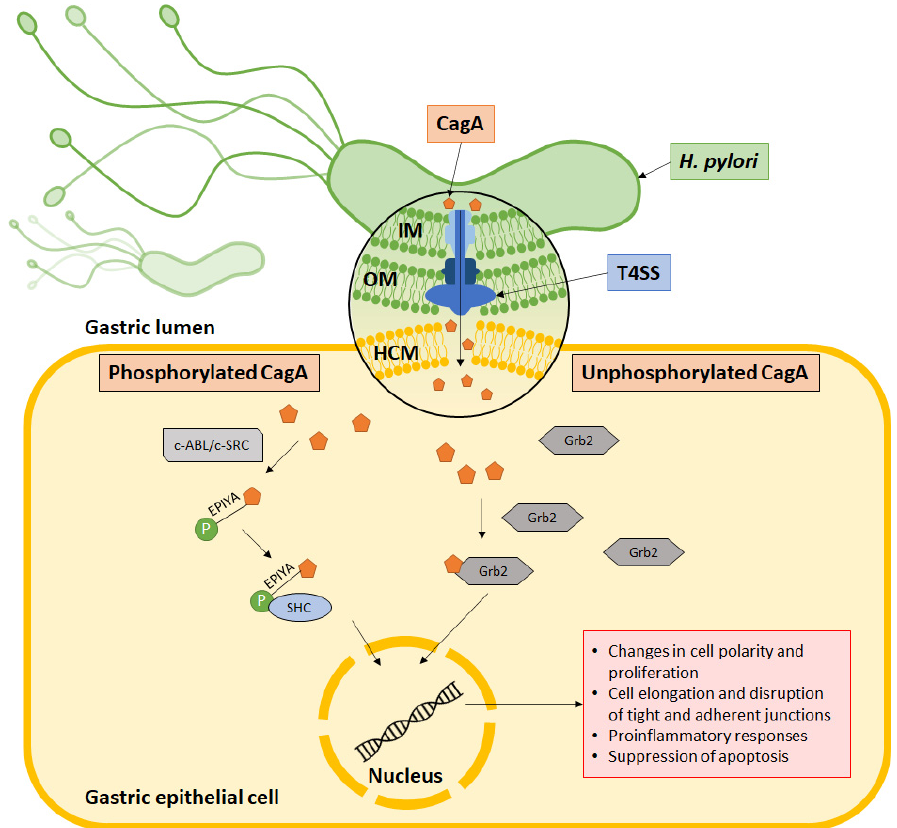
Figure 2. CagA’s mechanism of action. CagA is injected into the host cell via the type IV secretion system (T4SS), which is made up of an outer membrane ring occupying the outer membrane (OM), an inner membrane ring at the inner membrane (IM) and a pilus to inject CagA across the host cell membrane (HCM) into the cytoplasm. Some CagA undergo phosphorylation at the EPIYA motif via c-ABL or c-SRC and associates with the SHC domain to induce pathologies. Meanwhile, some CagA associate with Grb2 to induce pathology without undergoing